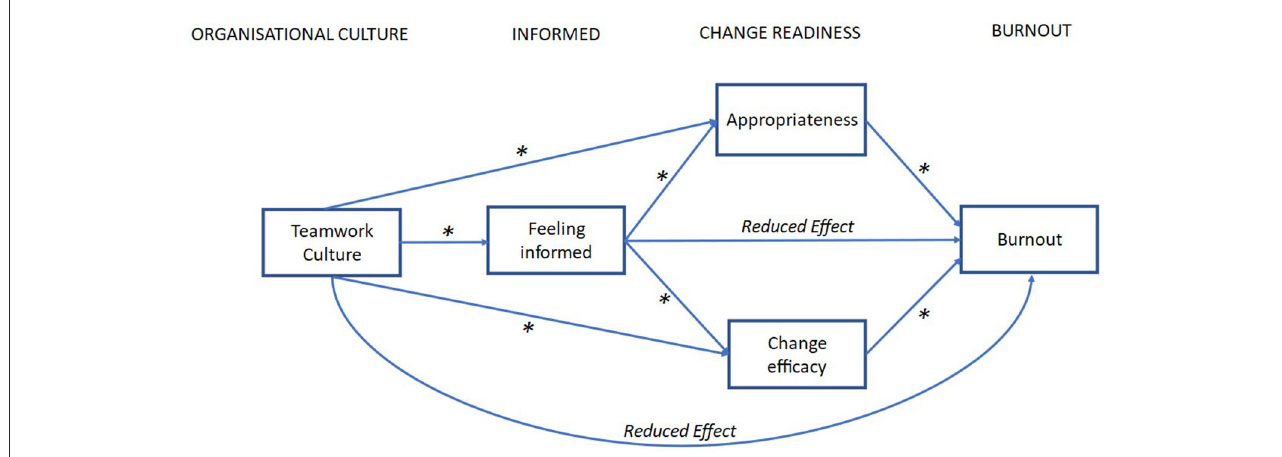
FIGURE1 Hypothesized explanatory path model for the influence of teamwork culture on burnout and the role of feeling informed and change readiness during organizational change. The model includes nine direct pathways with two serial mediations to two parallel mediators (change appropriateness and change efficacy); * = hypothesized significant